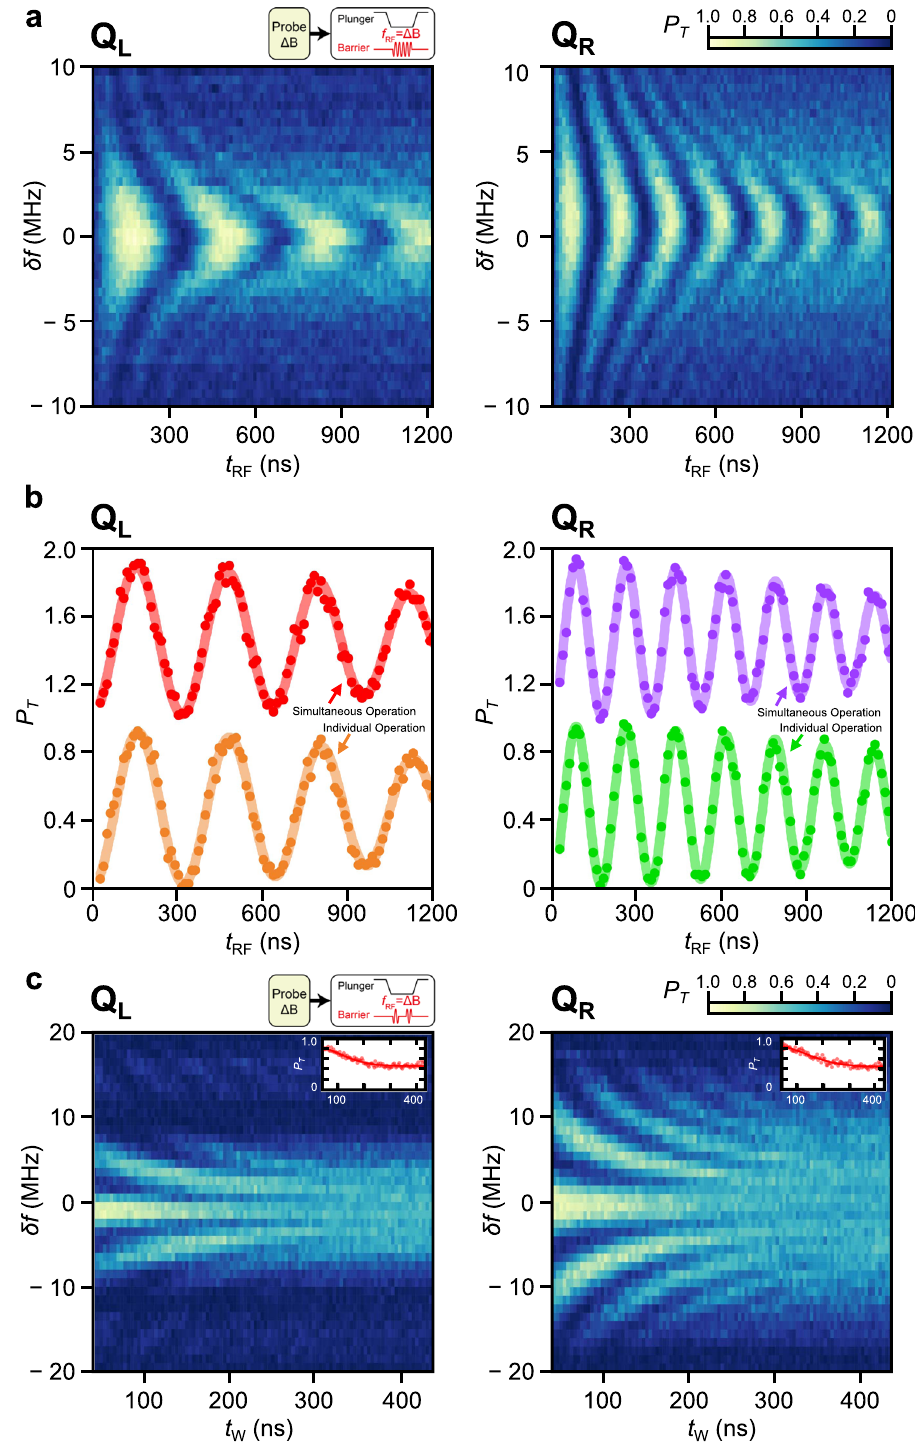
Fig. 2 Simultaneous driving of two ST 0 qubits. a Individually driven Rabi oscillation of the triplet return probability P T of Q L and Q R as a function of controlled detuning δ f and RF pulse duration t RF . b The representative P T oscillation of each qubit as a function of RF pulse duration for an individual and simultaneous operation. Solid curves are a fi t to sinusoidal functions with a Gaussian envelope. c Ramsey fringe of P T as a function of controlled detuning δ f and Ramsey delay t W , showing a typical Ramsey interference pattern. Inset: the line cut at the resonance condition. The solid curve is a fi t to a Gaussian decay function P T ð t W Þ ¼ A exp ð(cid:4)ð t W = T (cid:5) (183) ns for Q L (Q R